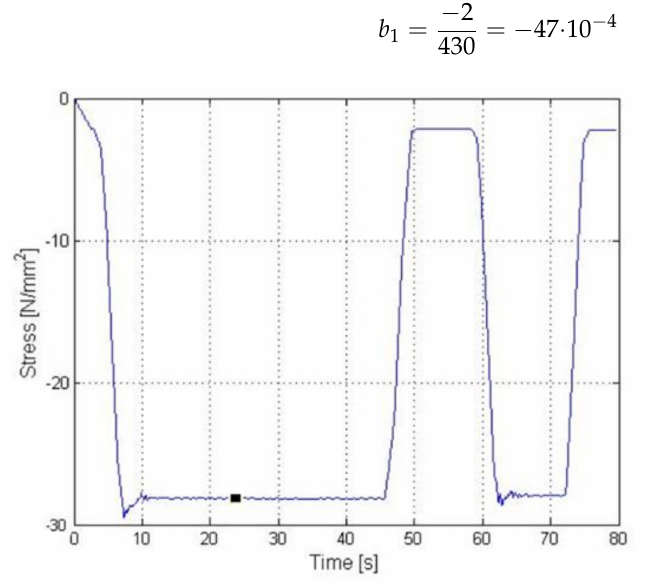
Figure 14. Strain gauge stress measurement result during the Z axis experiment.